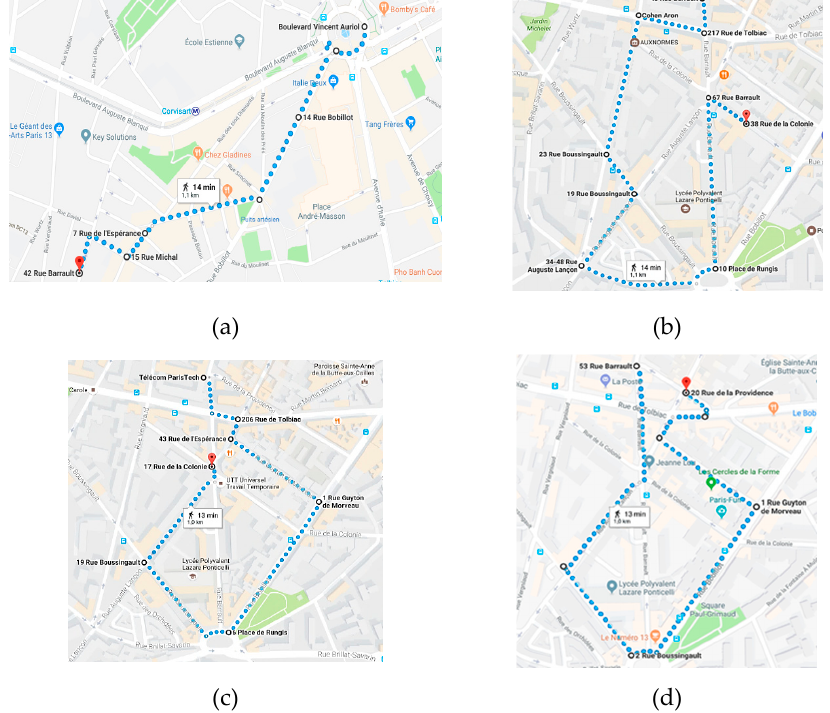
Figure 6 . The four routes that were navigated during the study. (a) The first route, navigated with the usual aid; (b) the second route, navigated with the AR glasses or bone conduction headphones; (c) the third route, navigated with the AR glasses or bone conduction headphones; and (d) the fourth route, navigated with the smartwatch.